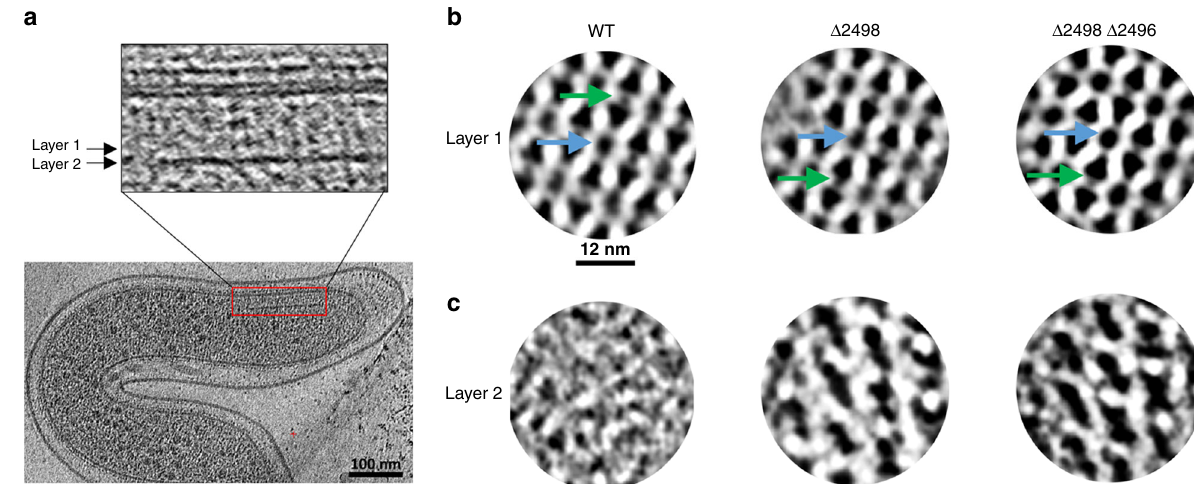
Fig. 3 Cryo-electron tomography of whole T. denticola ( Td ) cells reveals the protein arrangement of chemotaxis machinery. a Side-views of the membrane-associated chemotaxis apparatus illustrate the location of the receptor layer (Layer 1) and CheA:CheW baseplate (Layer 2). These layers are spaced ~90 Å from one another. b Sub-volume averaging of three Td strains reveals the universally conserved receptor trimer-of-dimer arrangement with 12 nm spacing between opposing trimer-of-dimer modules. Notably, density is apparent in the center of the receptor hexagons (blue arrows) and between some receptor trimer-of-dimer modules (green arrows). In general, the densities in Layer 1 of the wild-type (WT) strain are better resolved. c Sub-volume averages at Layer 2 reveal the organization of CheA. Density corresponding to CheA is only apparent in the two Td deletion mutants and CheA is arranged in a linear fashion. In this arrangement, the density between the trimer-of-dimer modules (green arrows) corresponds to the CheA P3